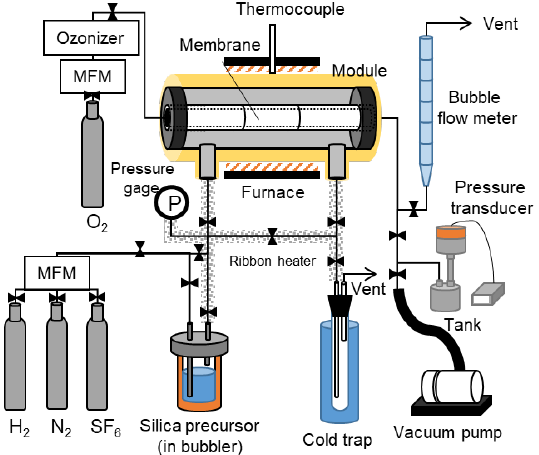
Figure 2. A schematic diagram of the counter diffusion CVD-gas permeation apparatus.